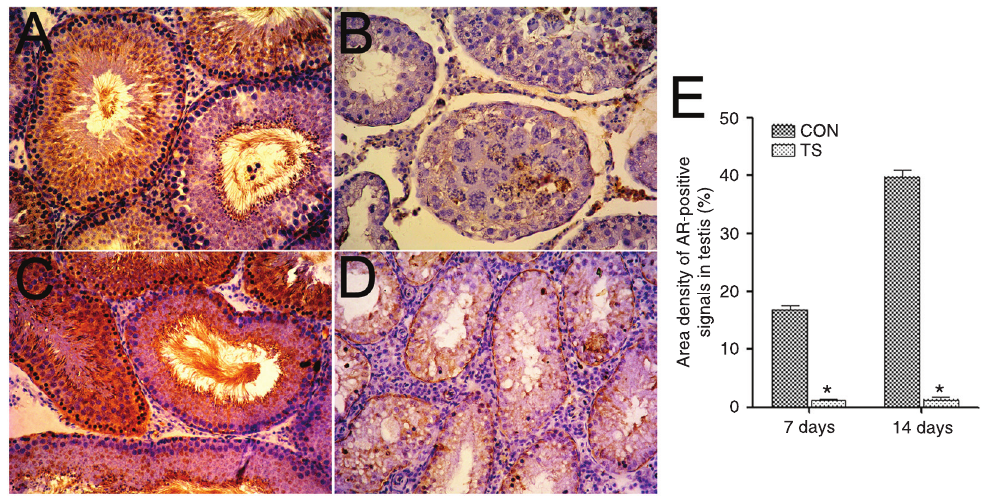
Figure 3. Localization and quantitative analysis of androgen receptor (AR) with immunohistochemical stain- ing. AR in the control (CON) groups ( A , not treated for 7 days; C , not treated for 14 days) and tail-suspended (TS) groups ( B , TS group for 7 days; D , TS group for 14 days). AR was detected using rabbit anti-AR antisera, biotinylated second antibody and horseradish peroxidase-labeled avidin chain working fluid. The immunohis- tochemical staining of AR resulted in brown or yellow color of the areas containing AR, which can be used to trace and measure AR. E , Relative signal intensity of AR in rat testis. *P < 0.01 compared to control (one-way ANOVA and Tukey test).